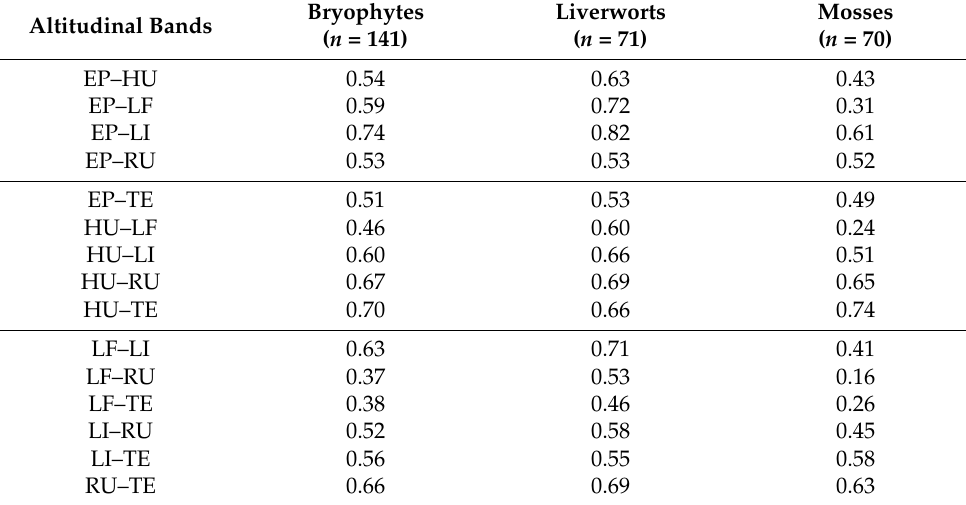
Table 5. Sørensen’s similarity indices (SSIs) between pairs of substrates in the Pico Island transect. The more similar the species composition between two different substrates, the closer the SSI gets to 1.00 (EP = epiphytic; HU = humicolous; LF = epiphyllic; LI = lignicolous; RU = rupicolous; and TE =